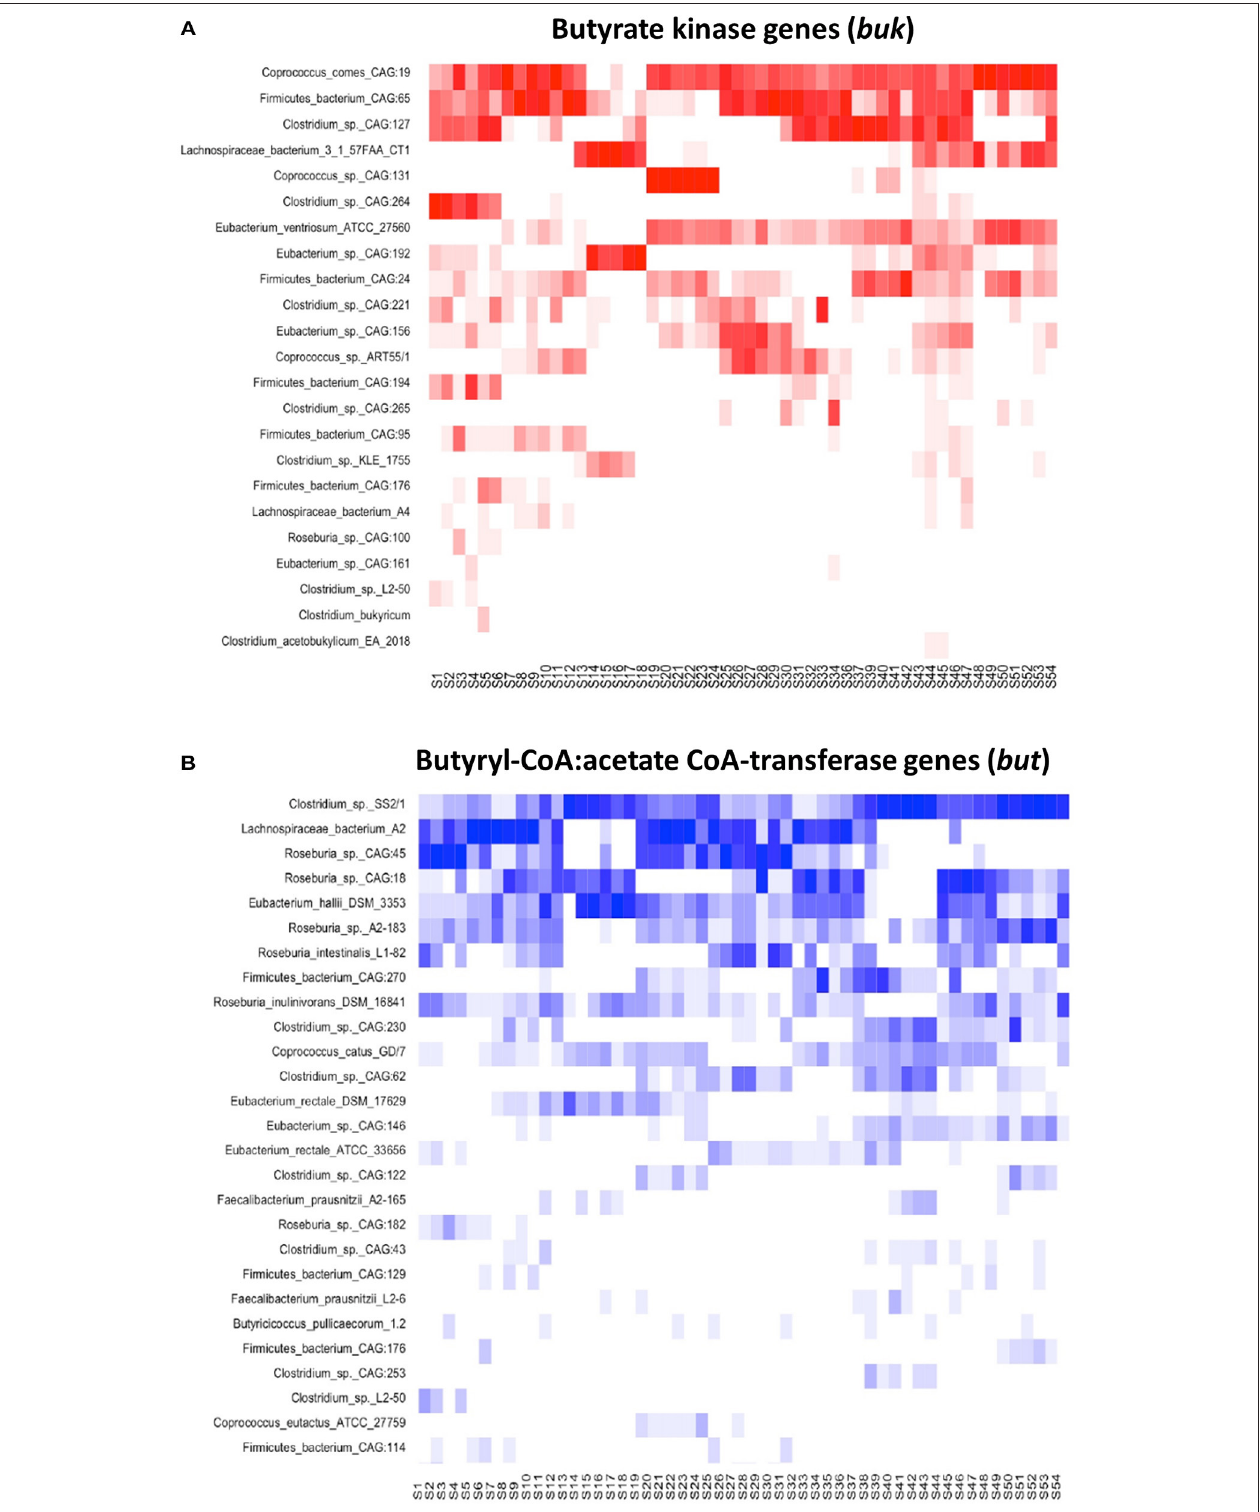
FIGURE 6 | A schematic representation of closest matches of buk (A) and but (B) gene sequences describing butyrate producing communities in 54 PlanHab samples.